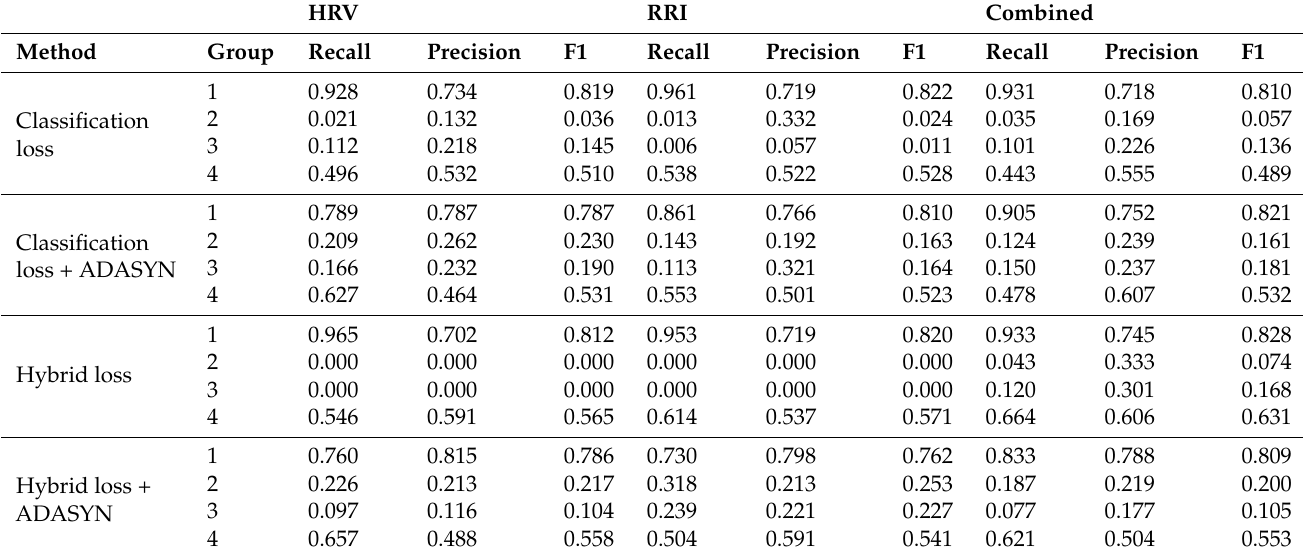
Table 7. Mean prediction performance for each age group based on the data type and